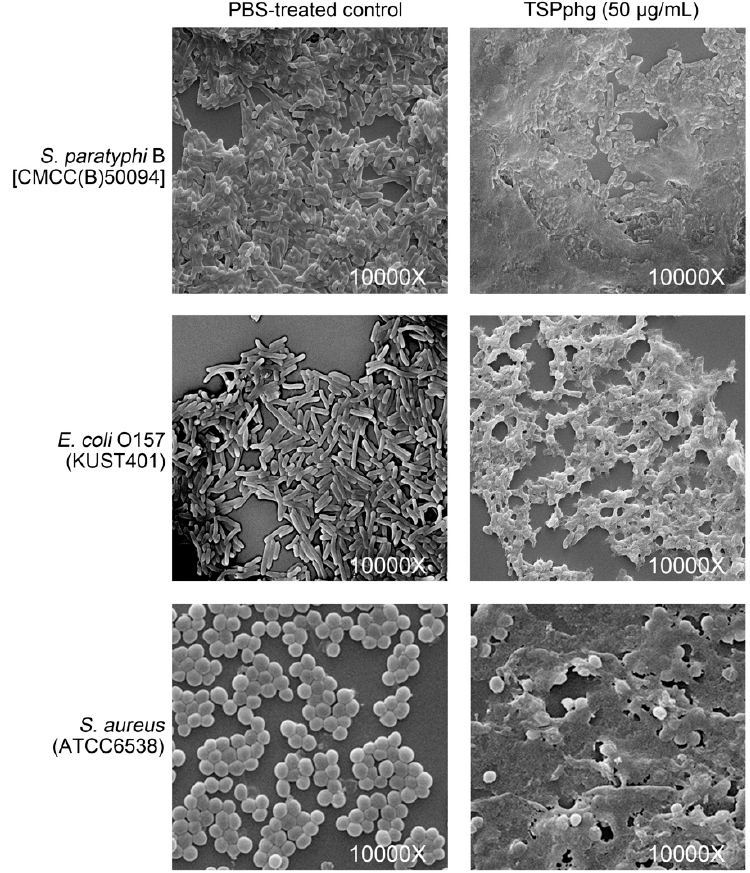
Figure 4. Scanning electron microscopy showing the effects of exogenous TSPphg treatment on the bacterial cell lysis of both Gram-negative ( S. paratyphi B and E. coli O157) and Gram-positive ( S. aureus ) strains. For all tests, the 10 5 CFU/mL of bacterial cells was treated with or without 50 μ g/mL TSPphg dissolved in PBS at 37 °C for 1 h. The magnification is 10,000 times the original size.